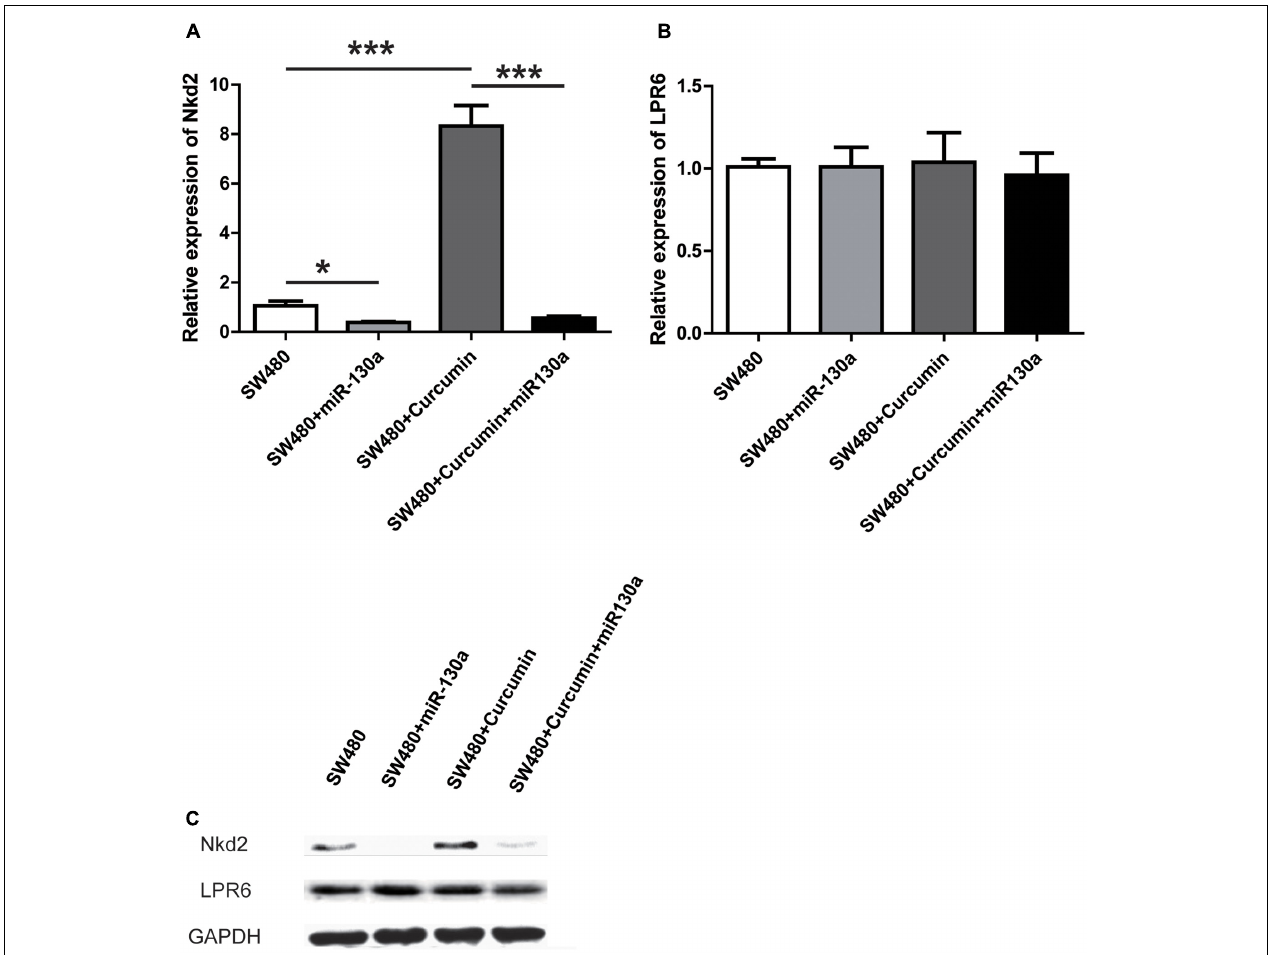
FIGURE 6 | miR-130 abolished the anti-proliferation effect of curcumin by downregulating nkd2. (A) RT-q-PCR of the mRNA level of Nkd2 in SW480 cells with the treatments as indicated. Data were represented as mean ± SD; n = 3 independent experiments. ∗ p < 0.05, ∗∗∗ p < 0.001. (B) RT-q-PCR of the mRNA level of LPR6 in SW480 cells with the treatments as indicated. Data were represented as mean ± SD; n = 3 independent experiments. (C) Western blot analysis of the protein level of NKD2 and LPR6 in SW480 cells with the treatment as indicated. n = 3 independent experiments and this panel presented one of these